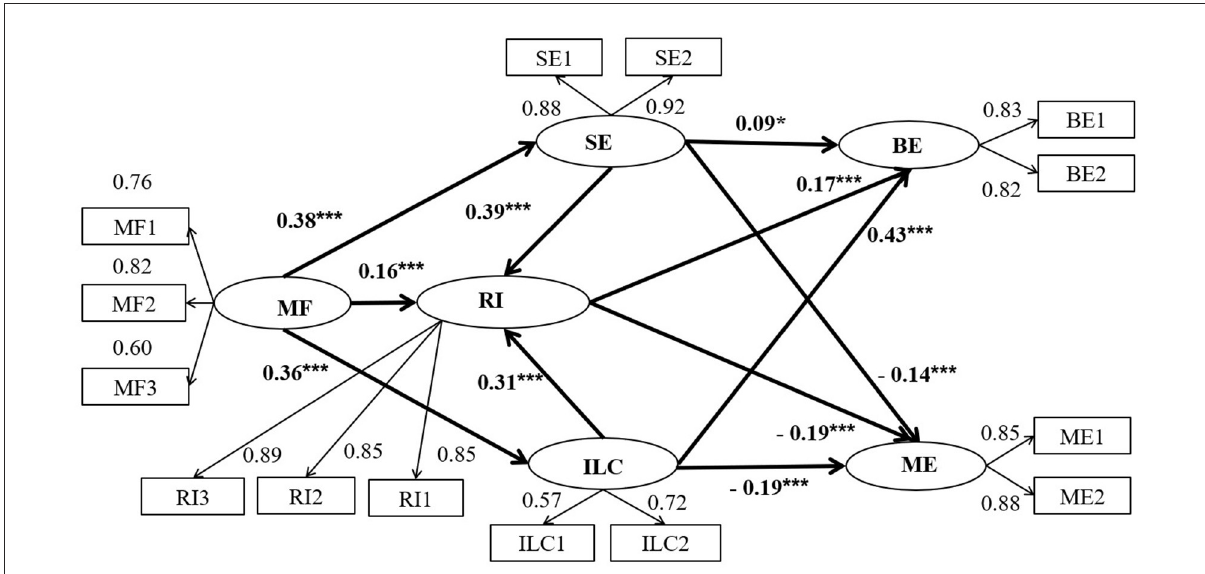
FIGURE1 The mediation model factor loadings are standardized. MF1, MF2 and MF3 represent 3 parcels of Mindfulness, ILC1 and ILC2 represented 2 parcels of Internal Locus of Control, SE1 and SE2 represent 2 parcels of Self-Esteem, RI1, RI2 and RI3 represent 3 parcels of Resilience, BE1 and BE2 represent the two parcels of Benign Envy, ME1 and ME2 represent the two parcels of Malicious Envy. * p < 0.05, ** p < 0.01, *** p <